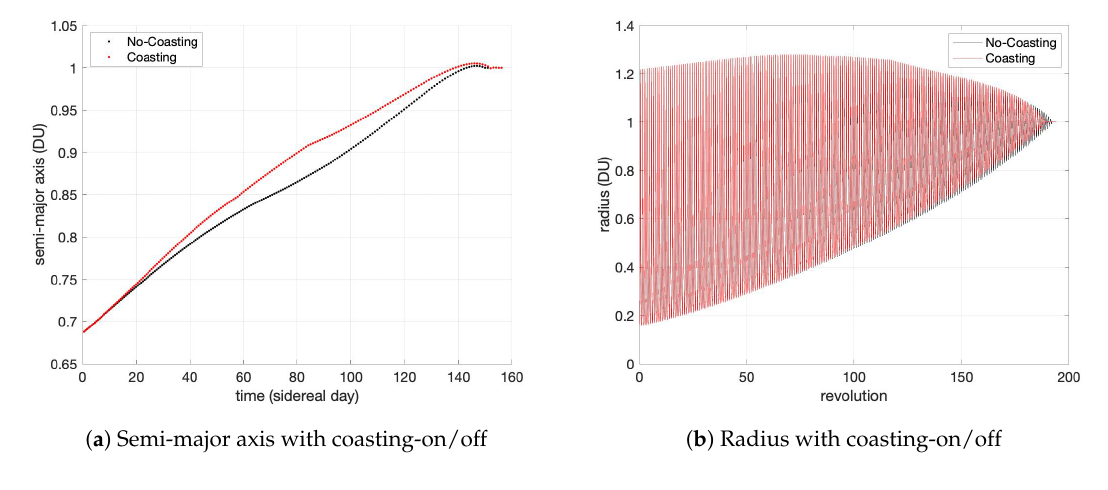
Figure 12. Trajectory and control angles of Super-GTO to GEO transfer.